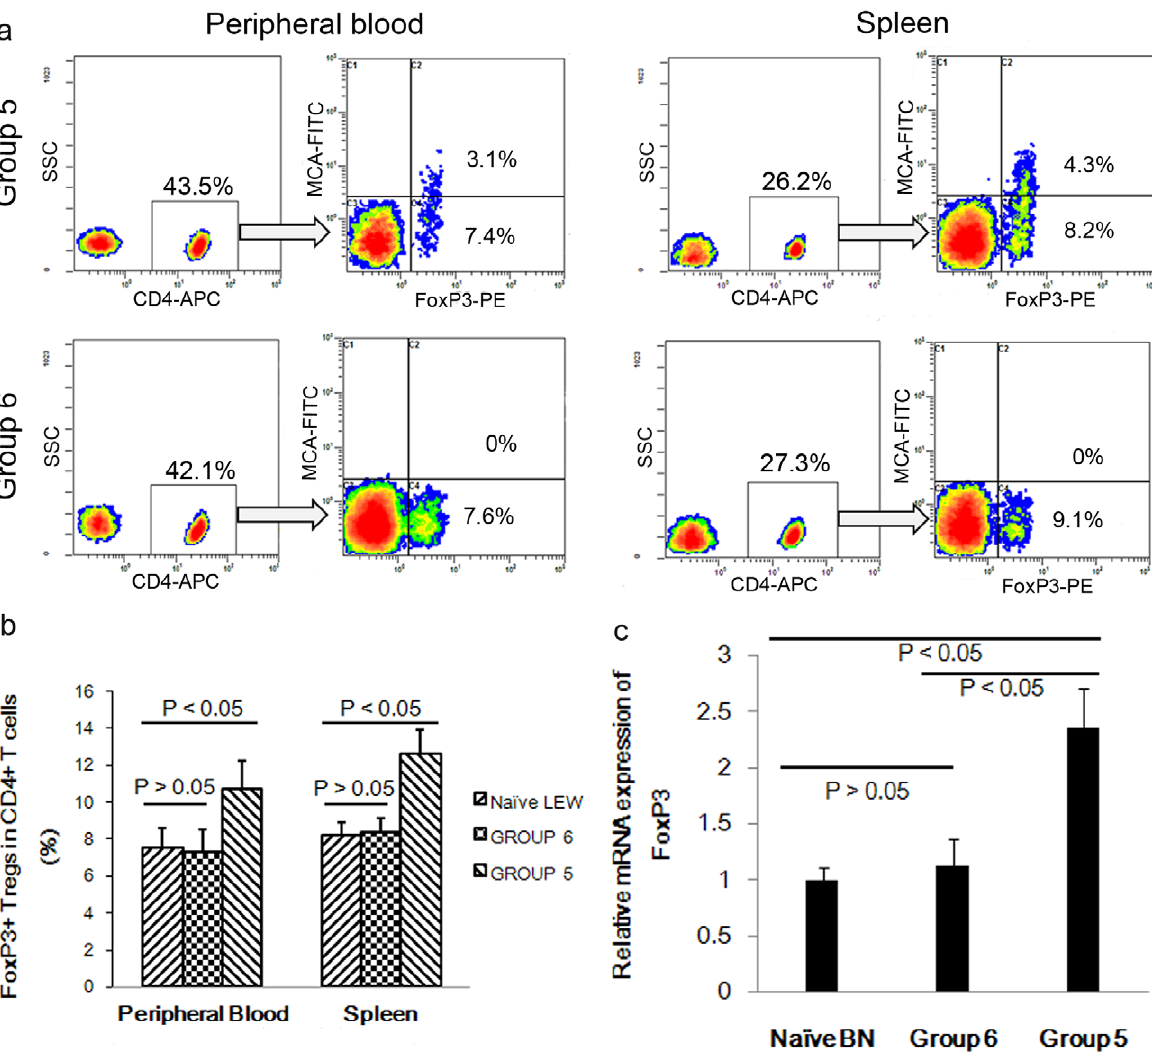
Figure 6. Location of FoxP3 + Tregs in rats receiving CsA treatment. (a) Representative dot plots of donor-specific FoxP3 + Tregs in peripheral blood and spleen from allograft recipients in groups 5 and 6 at the end of the observation period. Mononuclear cells were obtained by Ficoll solution centrifugation, followed by magnetic isolation of CD4 + T cells. Isolated CD4 + T cells were then co-stained with anti-rat mAb RT1 n -FITC and intracellularly stained with anti-mouse/rat Foxp3-PE. All cells were analyzed by flow cytometry. The results demonstrated that donor-specific FoxP3 + Tregs were exclusively obtained in both the peripheral blood and spleens of long-term allograft recipients in group 5. (b) Further analysis indicated an average proportion of 10.7% 6 1.1% versus 7.6% 6 1.6% and 12.6% 6 0.7% versus 8.3% 6 1.1 FoxP3 + Tregs located in the peripheral blood and spleen in group 5 and 6, respectively, with significant differences (n=6, P , 0.05). (c) Expression of FoxP3 mRNA in the allografts was analyzed by real-time PCR normalized to GAPDH. Significantly higher levels of FoxP3 were observed in group 5 (n=6, P ,